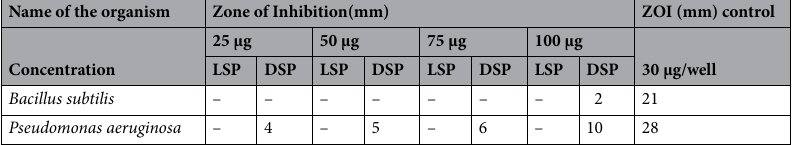
Table 1. Antibacterial activity of Latex coated SPIONs against Bacillus subtilis and Pseudomonas aeruginosa. LSP latex coated SPIONs, DSP drug loaded nanoconjugate.